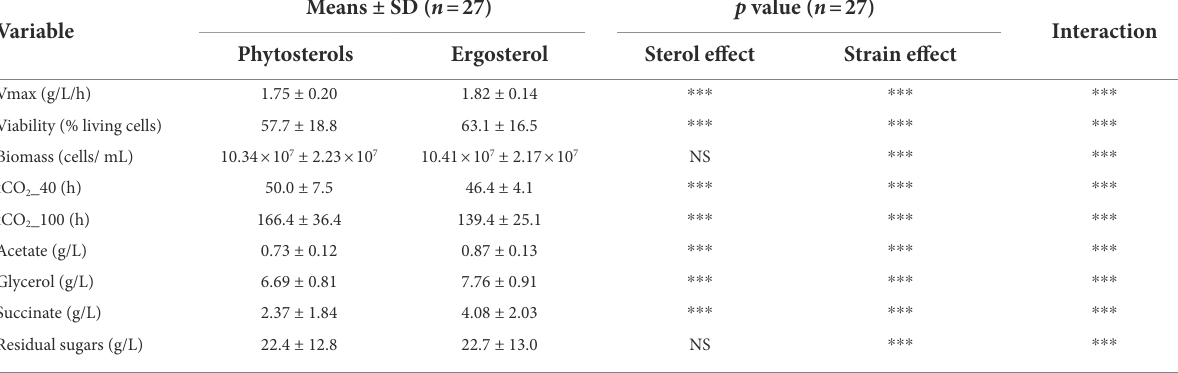
TABLE 3 Means, standard deviations (SD) and significance for the high sugars content experiment. Means ± SD ( n = Variable